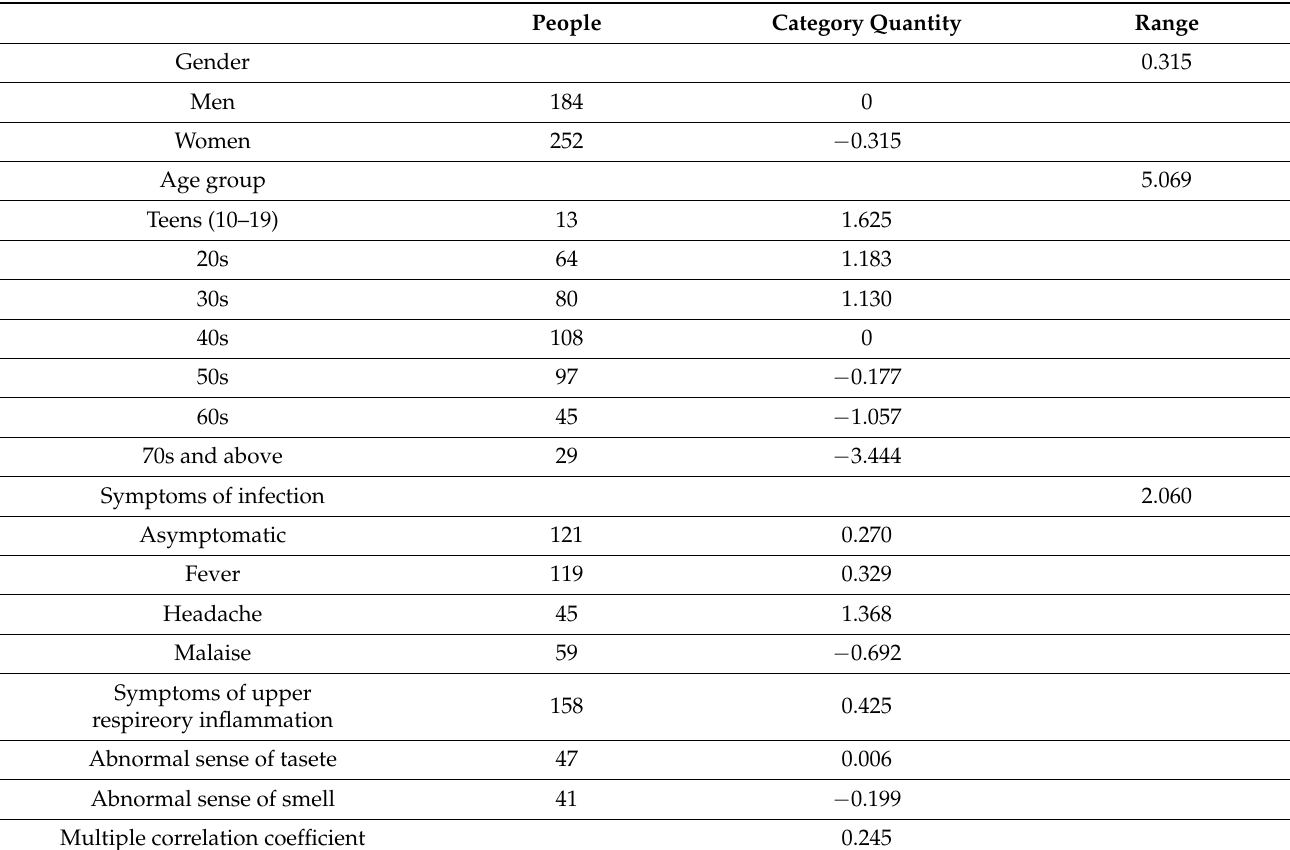
Table 2. Quantification I based classification of K6 scores ( n = 436).